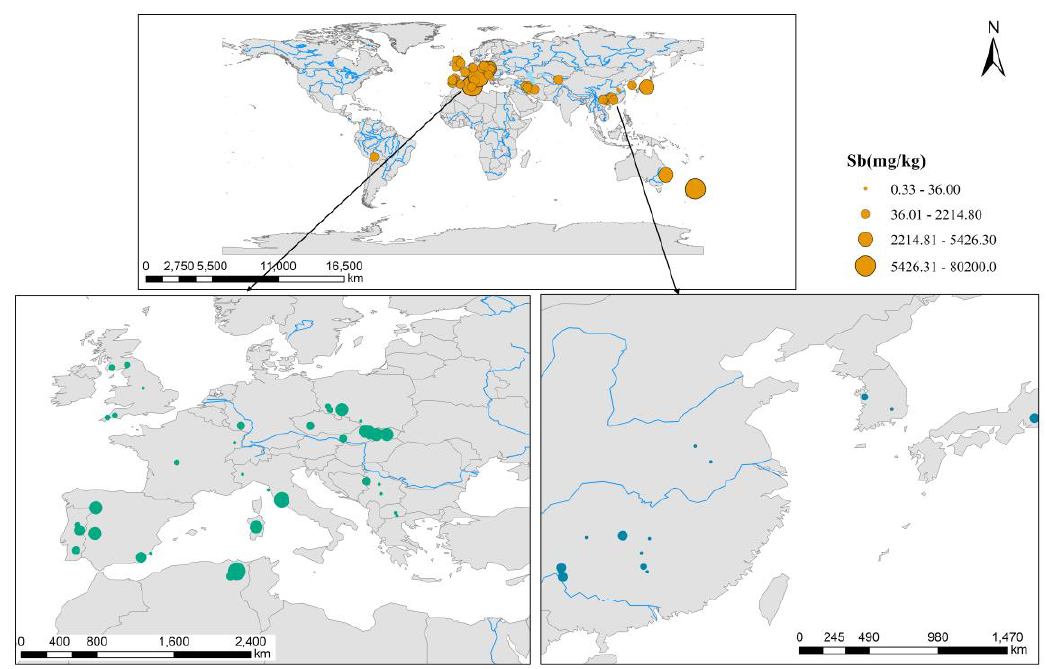
Figure 2. Spatial distribution of Sb concentrations in soils from different regions based on existing data. Specific regions from China and the European countries are enlarged. Changing the color of the orange dots into green and blue is just for clarity.